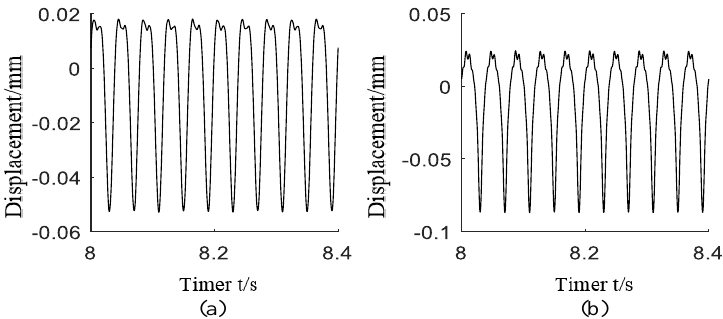
Figure 8. Time domain waveform of generator rotor vibration: ( a ) misalignment 3 mm, short-circuit 1%; ( b ) misalignment 3 mm, short-circuit 10%.